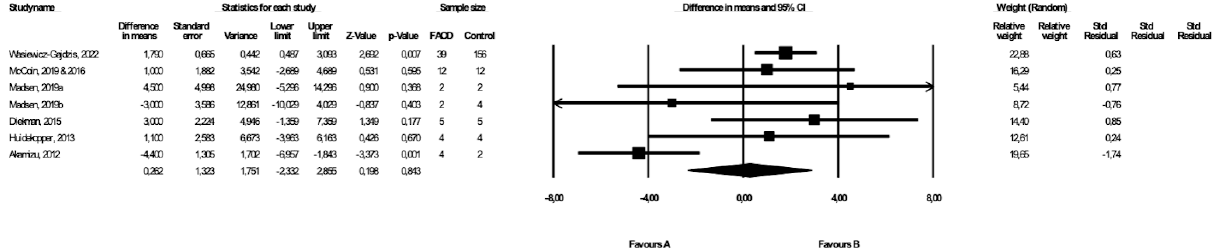
Figure 3. Forest plot—comparison of BMI in FAOD patients vs. controls [14,15,17–20,25].